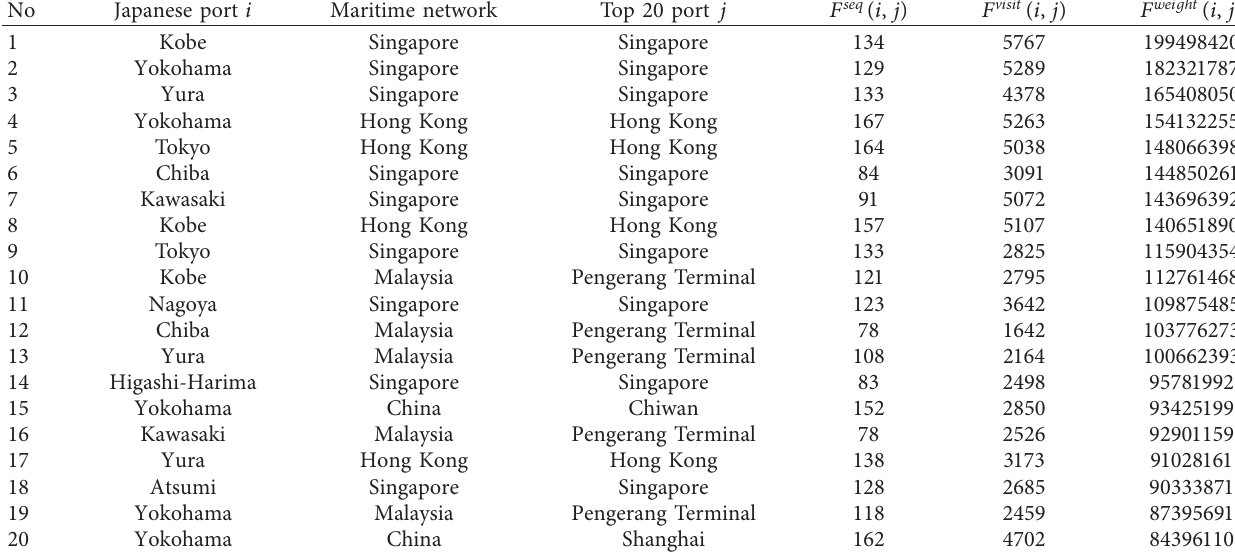
Table 6: Top 20 connections between Japan and the